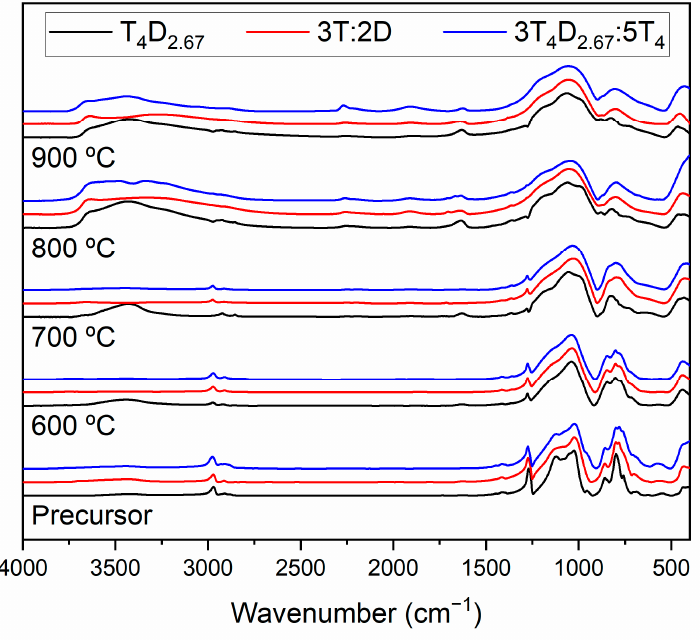
Figure 9. IR spectra of materials obtained at 600, 700, 800 and 900 °C from T 4 D 2.67 , 3T:2D and